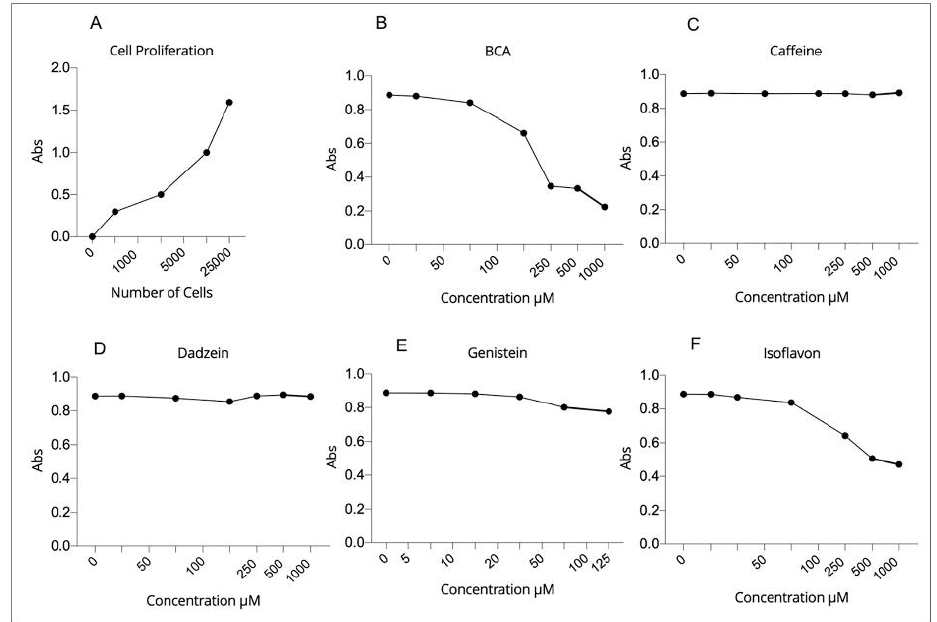
Figure 2. ( A ) Cell proliferation assay for establishing the number of cells to use for further tests. ( B – F ) Cytotoxicity assay for evaluation of the toxicity effects of bitter compounds on hGL5 cells, using cell counting kit-8 (Abcam). The nontoxic concentration for each compound was calculated: 10 µM for BCA ( B ), 300 µM for caffeine ( C ), 500 µM for daidzein ( D ), 5 µM for genistein ( E ) and 25 µM for isoflavone ( F ).